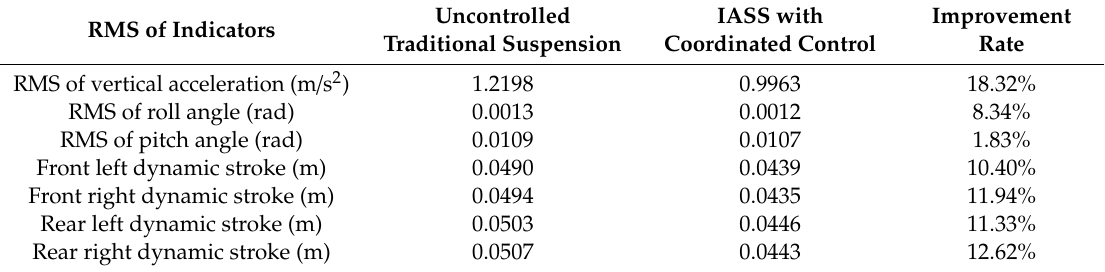
Figure 24. Dynamic stroke for front left suspension under the straight condition. Table 3. Test results of the root mean square (RMS) value of each index under the straight condition. Uncontrolled IASS with Improvement RMS of Indicators Traditional Coordinated Rate RMS of vertical acceleration (m / s 2 Suspension Control